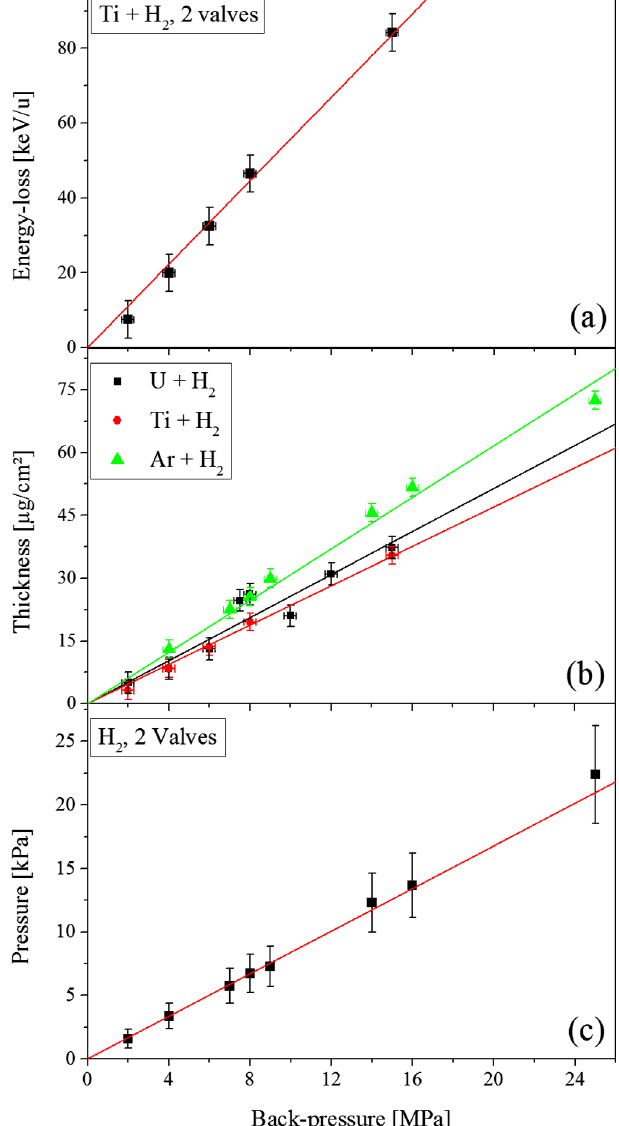
FIG. 4. (a) Energy-loss measurements for 50 Ti on H 2 gas at 1 . 4 MeV = u as a function of the back-pressure, using both gas valves. The red line represents a linear function fitted to the measurement data. (b) Estimated thickness of the H 2 gas target at 1 . 4 MeV = u depending on the back-pressure on the gas valves. The different lines represent linear functions fitted to the measurement data with corresponding equal color. (c) Pressure measurement using the piezoelectric pressure gauge near the interaction zone of the stripper with H 2 gas. The pressure increases linearly with increasing back-pressure on the valves. The red line represents a linear function fitted to the measurement